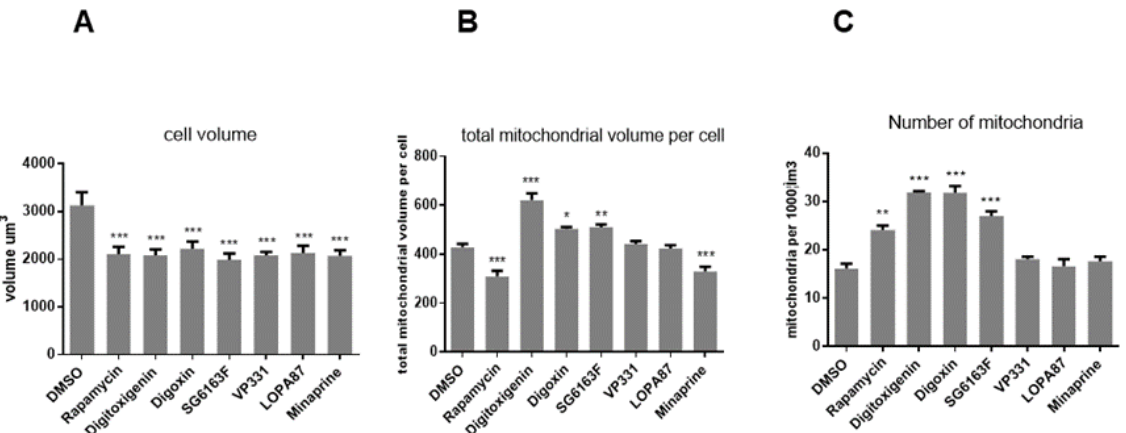
Figure 6. Effect of selected compounds on mitochondrial volume. RNVCs were treated with 1 µM compounds for 6 h and labeled with 4 µM calcein to determine the effect of compounds on the mitochondrial volume ( A ). Mitochondria were labeled with 200 nM Mitotracker to evaluate the total volume of mitochondria per cell ( B ) and quantify the number of individual mitochondria per cell ( C ). At least 150 cells were analyzed using a Leica confocal microscope and IMARIS software. Data are presented as mean ± SEM with one-way ANOVA, Sidak’s multiple comparisons test. *, p < 0.05, **, p < 0.01, ***, p < 0.001 vs. DMSO. Experiments were repeated three times.